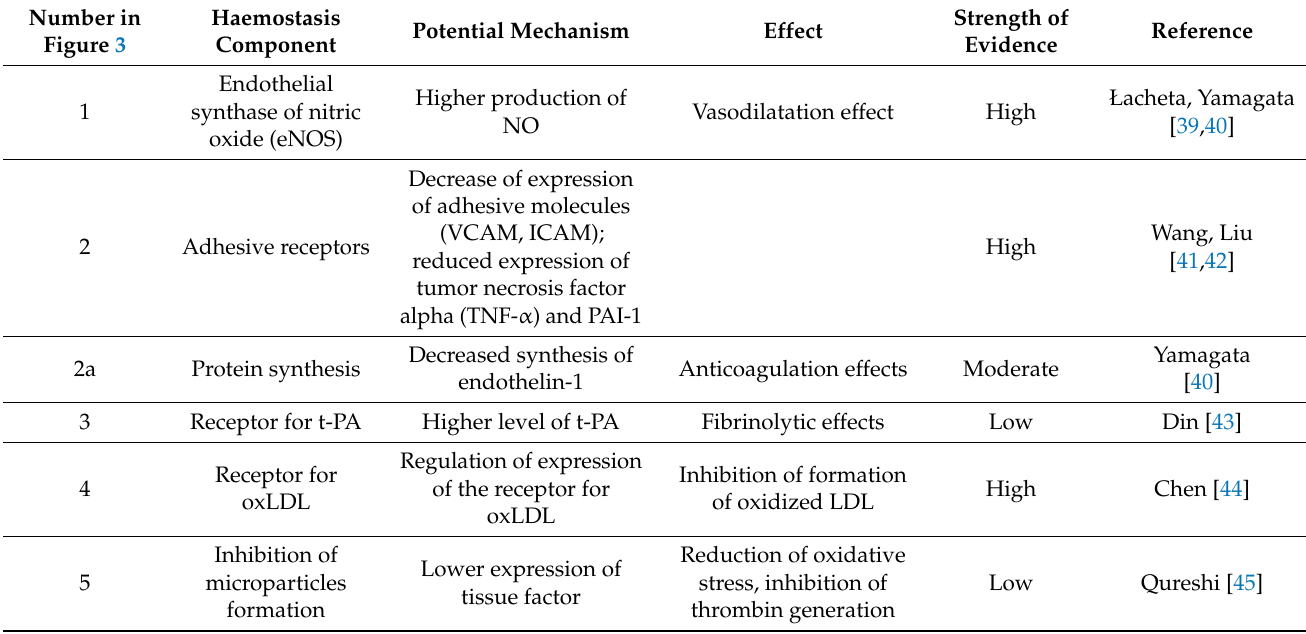
Table 2. Potential mechanisms of effects of EPA and DHA on